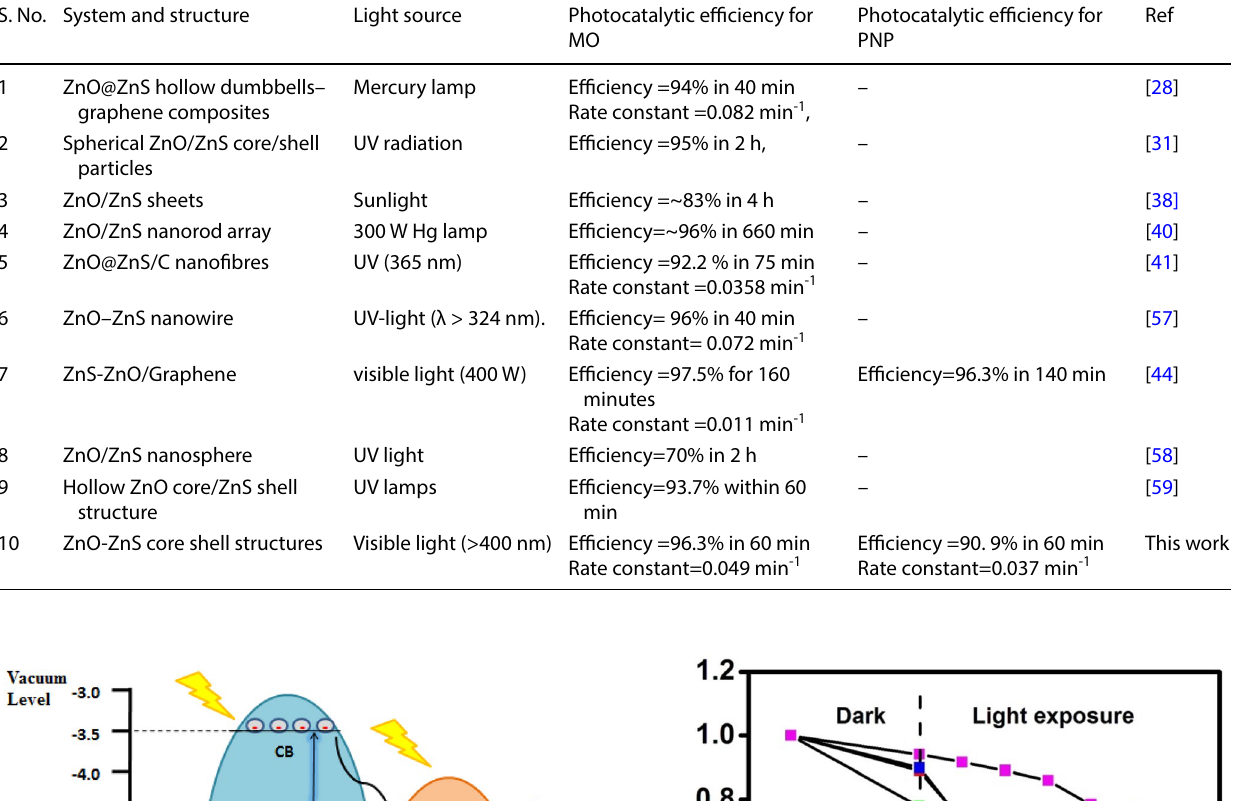
Table 4 Comparison of ZnO–ZnS core shell heterostructures with literature